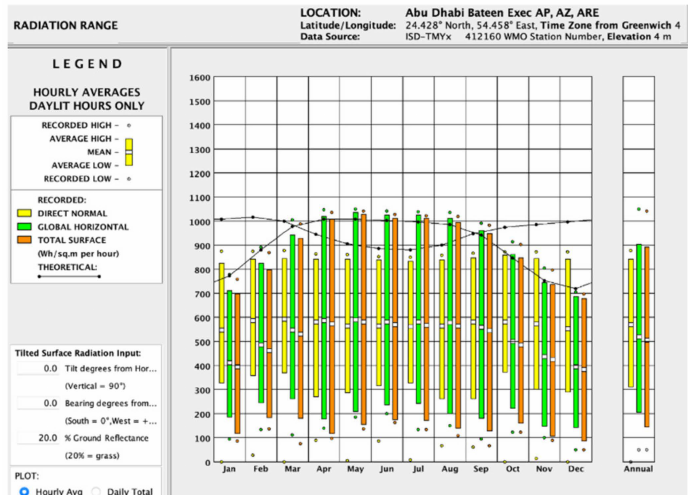
Figure 3. Radiation range for Abu